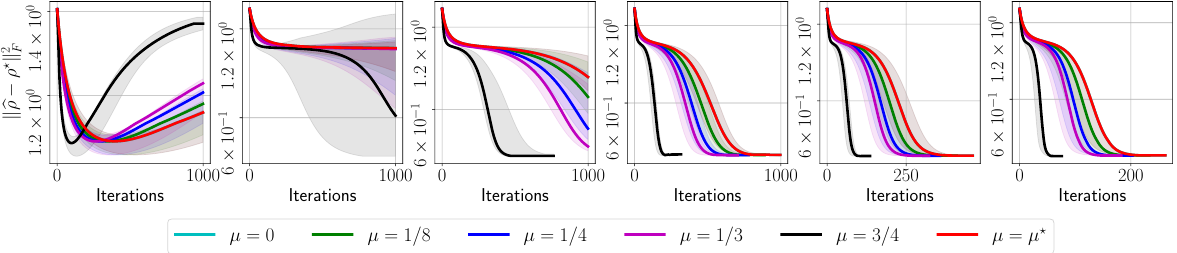
( 6 ) circuit using real measurements from −